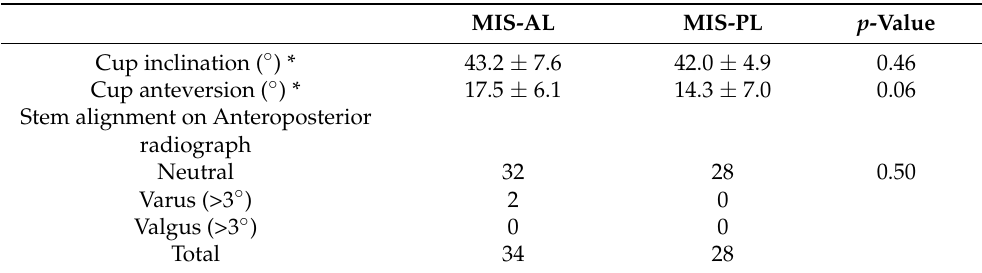
Table 3. Postoperative radiographic findings.